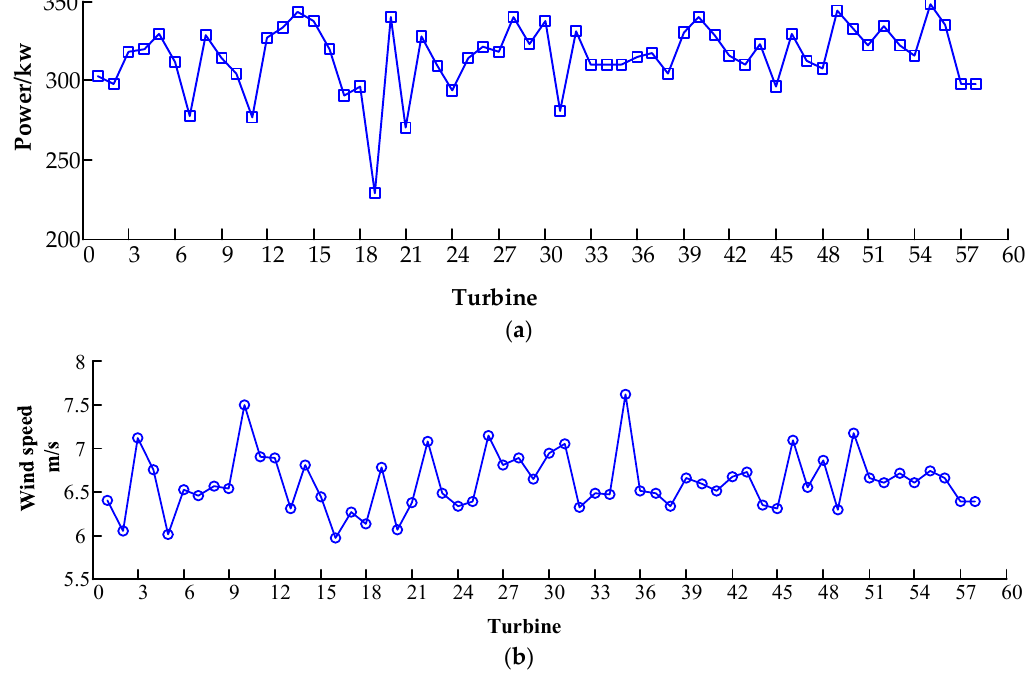
Figure 9. The wind power fluctuation of the turbine about ( a ) wind power and ( b ) wing speed.